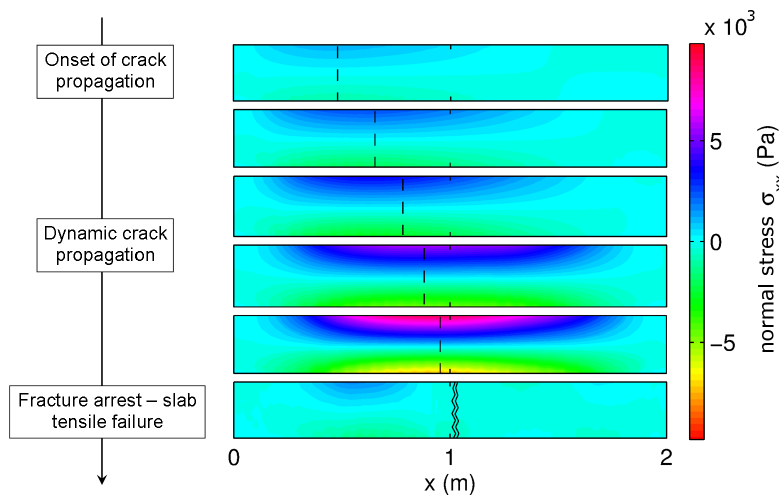
Figure 14. Evolution of the normal stress σ xx in the slab during the process of crack propagation for a case #1 simulation and a density of 250kgm − 3 with a tensile strength of 10kPa. The normal stress σ xx was calculated for each grain from contact forces according the Love homogenization formula and linearly interpolated between grains. The dashed lines represent the position of the crack tip in the